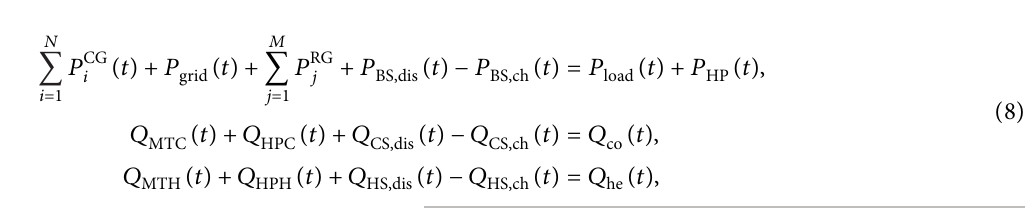
Figure 1: Microgrid energy design and power